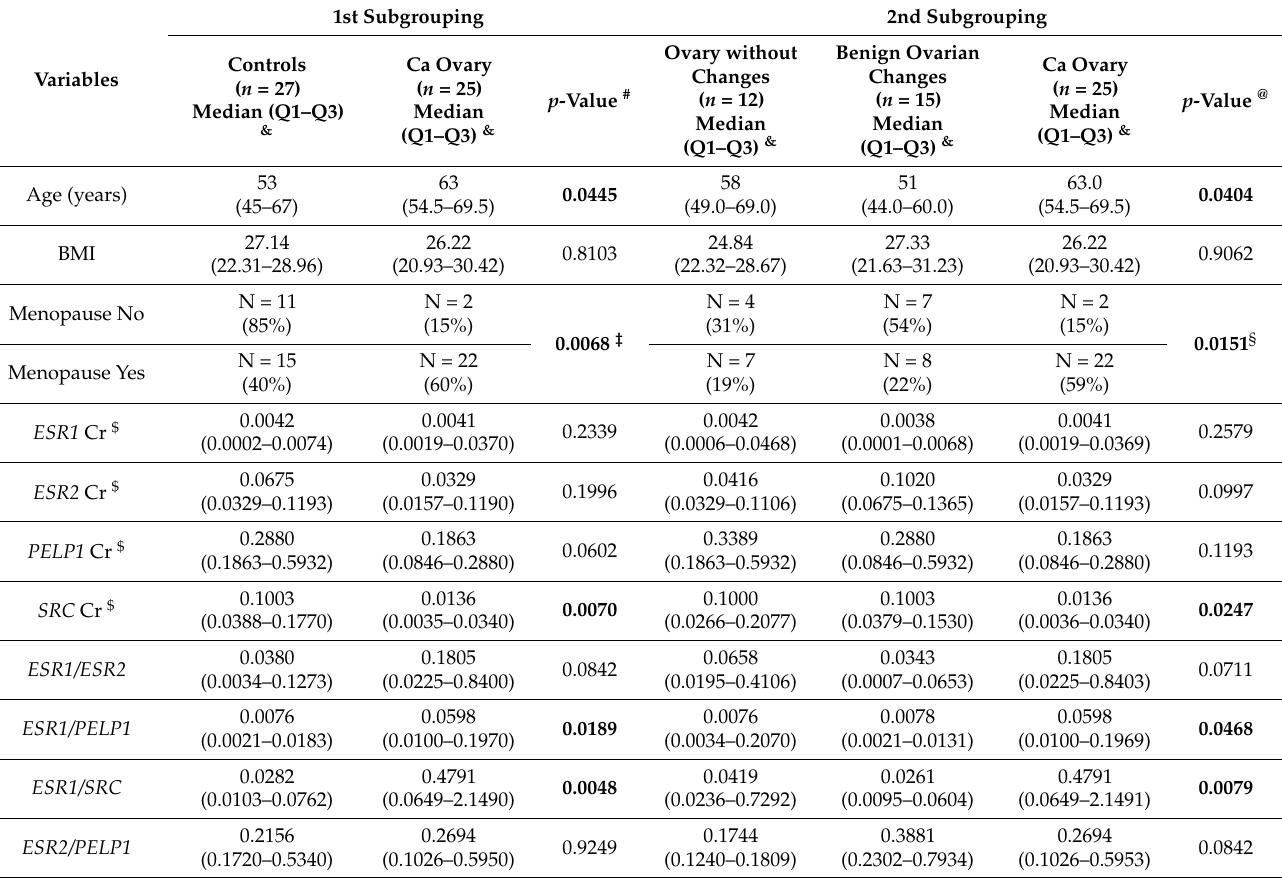
Table 1. Characteristics of study groups and results of the qPCR reactions